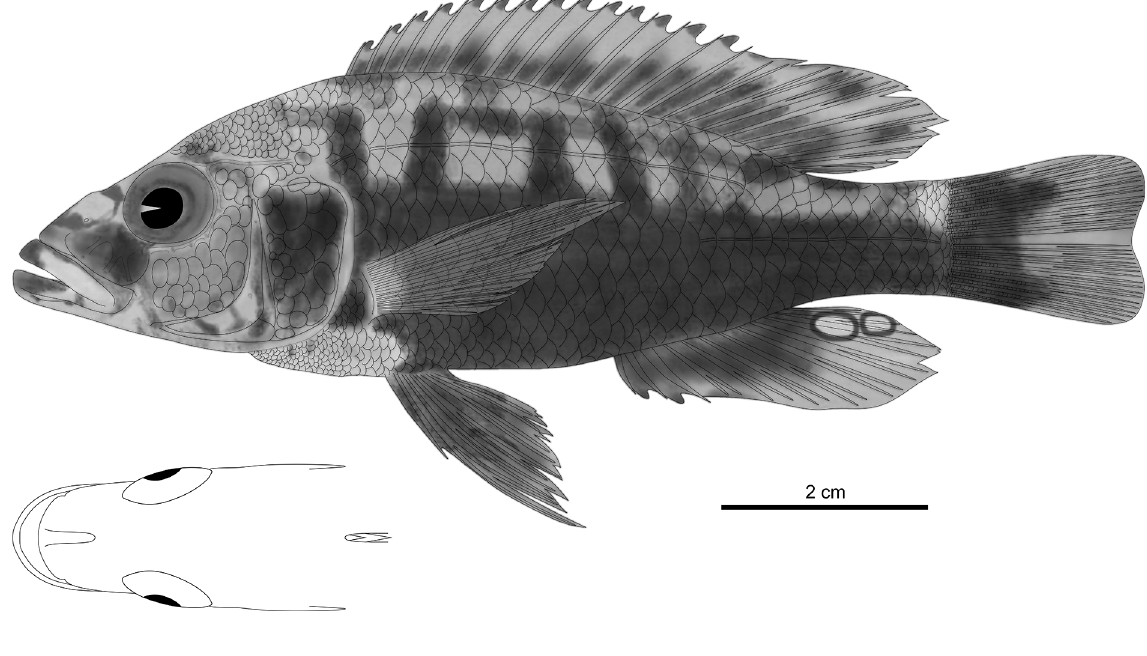
Fig. 32. Haplochromis pardus sp. nov., holotype, ♂, 89.2 mm SL (RMCA 2016.035.P.0202). Drawn by N.